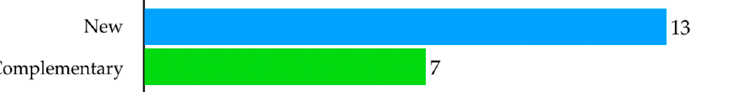
Figure 4. Number of proposed new developments and complementary contents that are adjacent to already existing wellness and spa or leisure facilities.